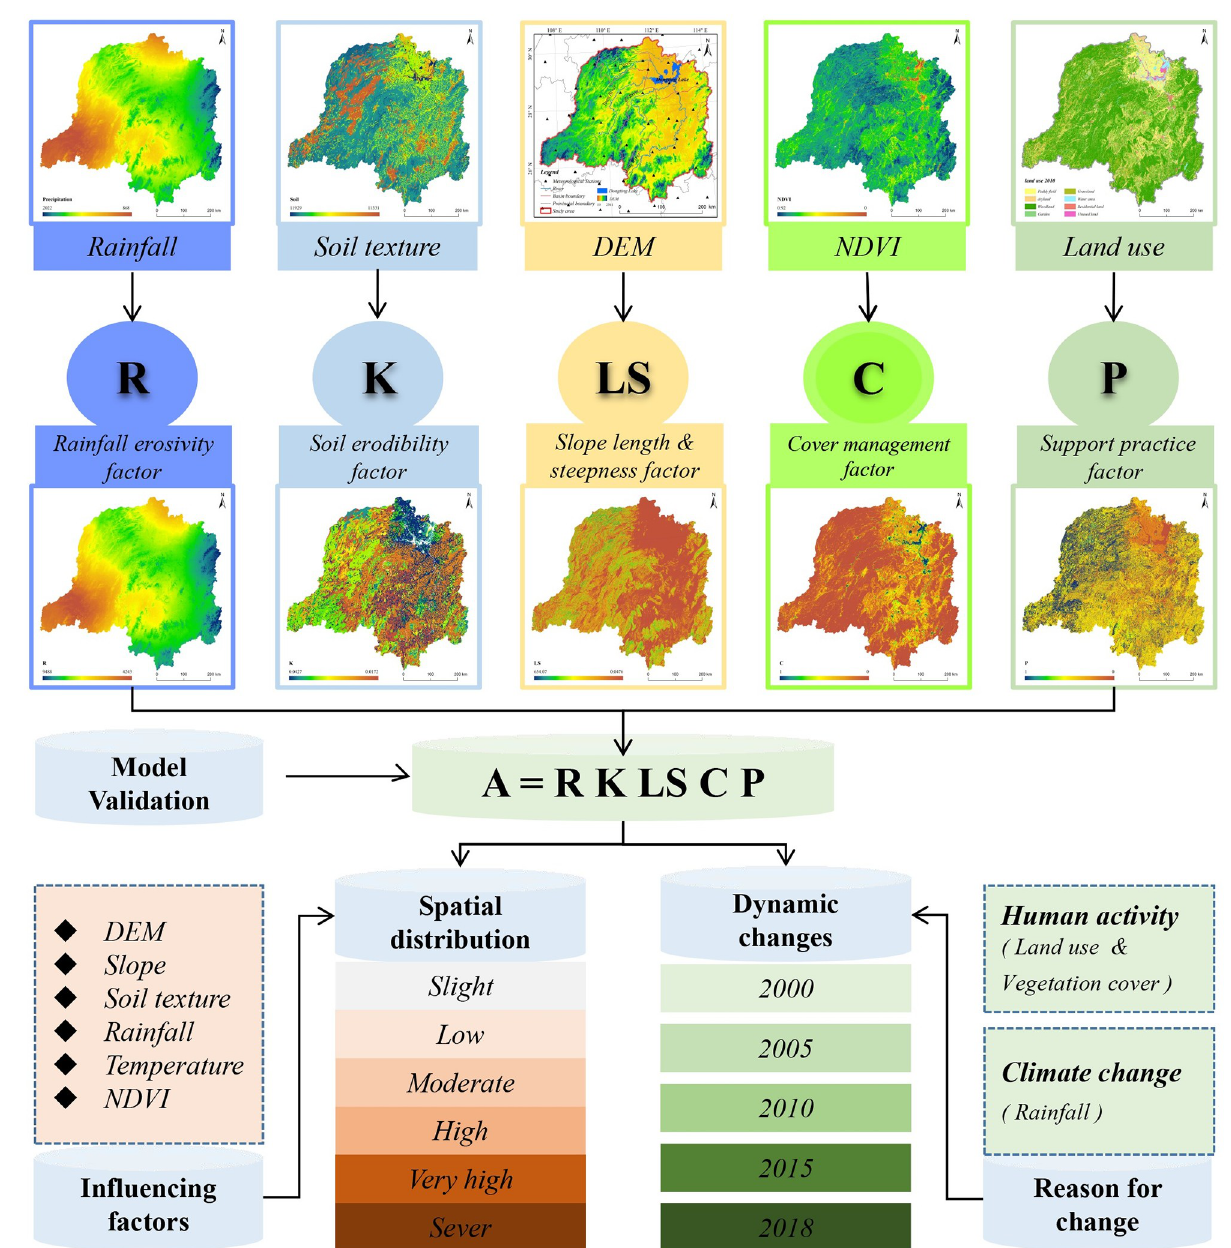
Fig 2. Flowchart of the spatiotemporal evolution of soil erosion and its influencing factors. The image was created using ARCGIS 10.2 software with the authors’